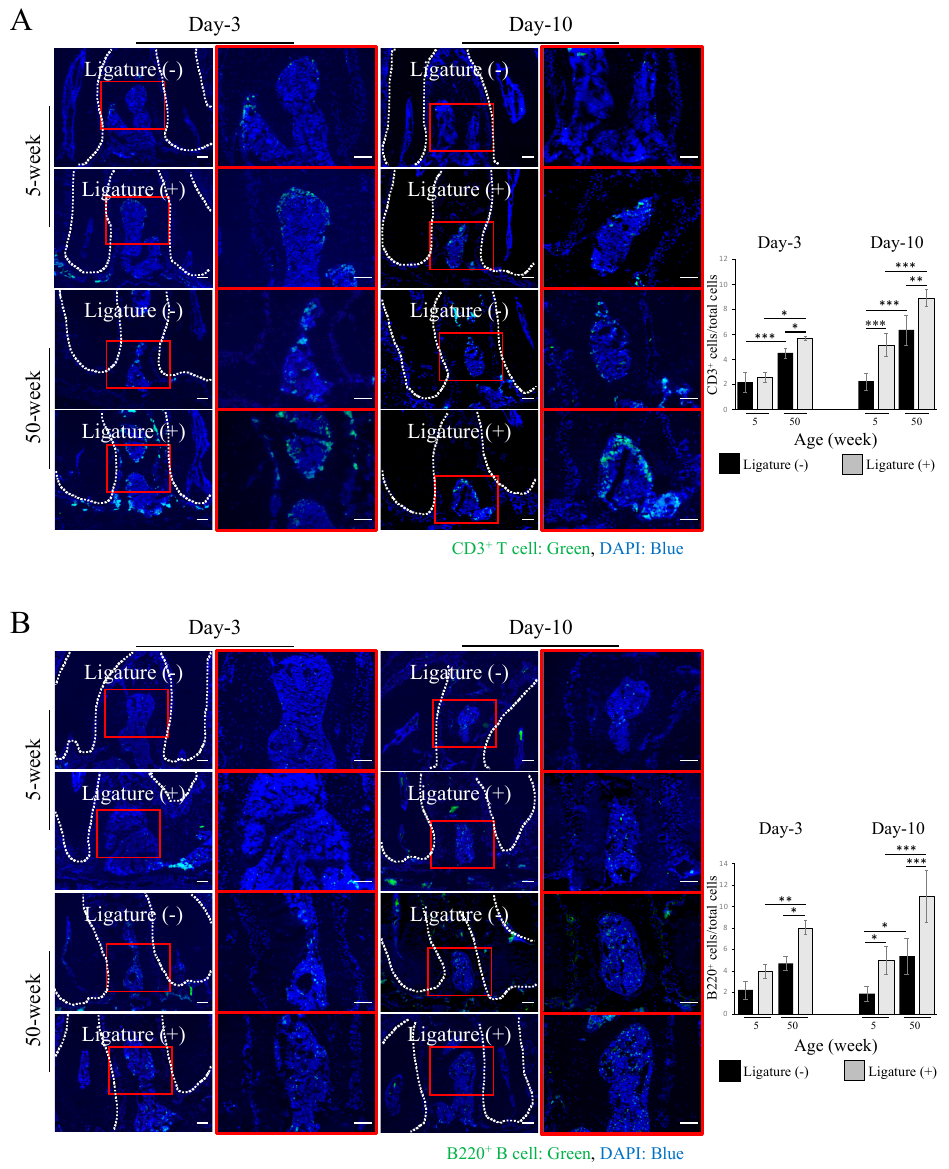
than in young mice (3.99 ± 0.65, 5 ± 1.24), respectively (Figure 3B). Furthermore, after ligation, the levels of inflammatory cytokines, including Il-1 β , Tnf- α , Ifn- γ , were all significantly increased at day- 10 in aged mice (Figure S2).